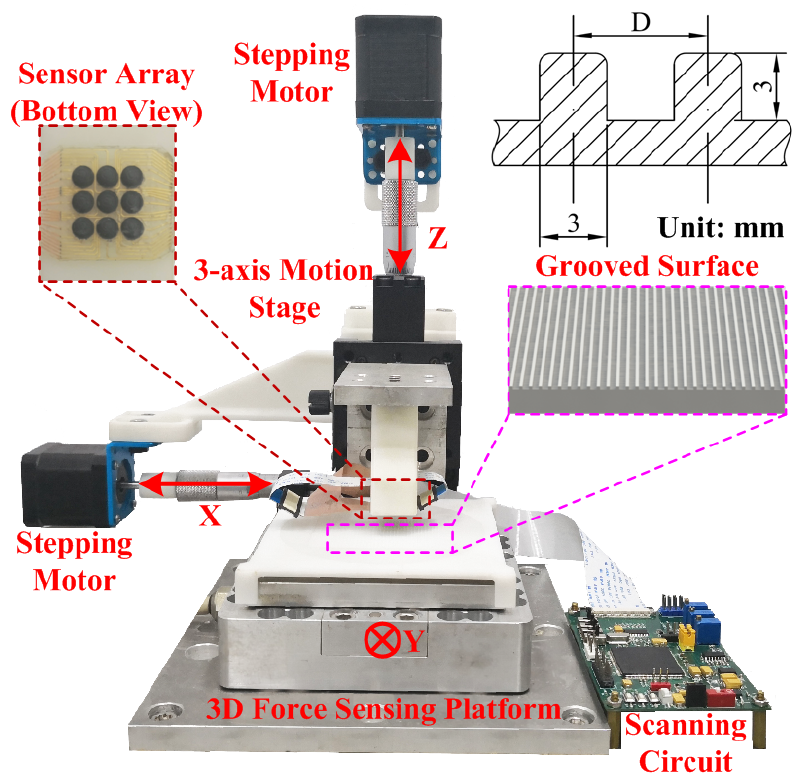
Figure 4. Experimental setup for the validation tests.